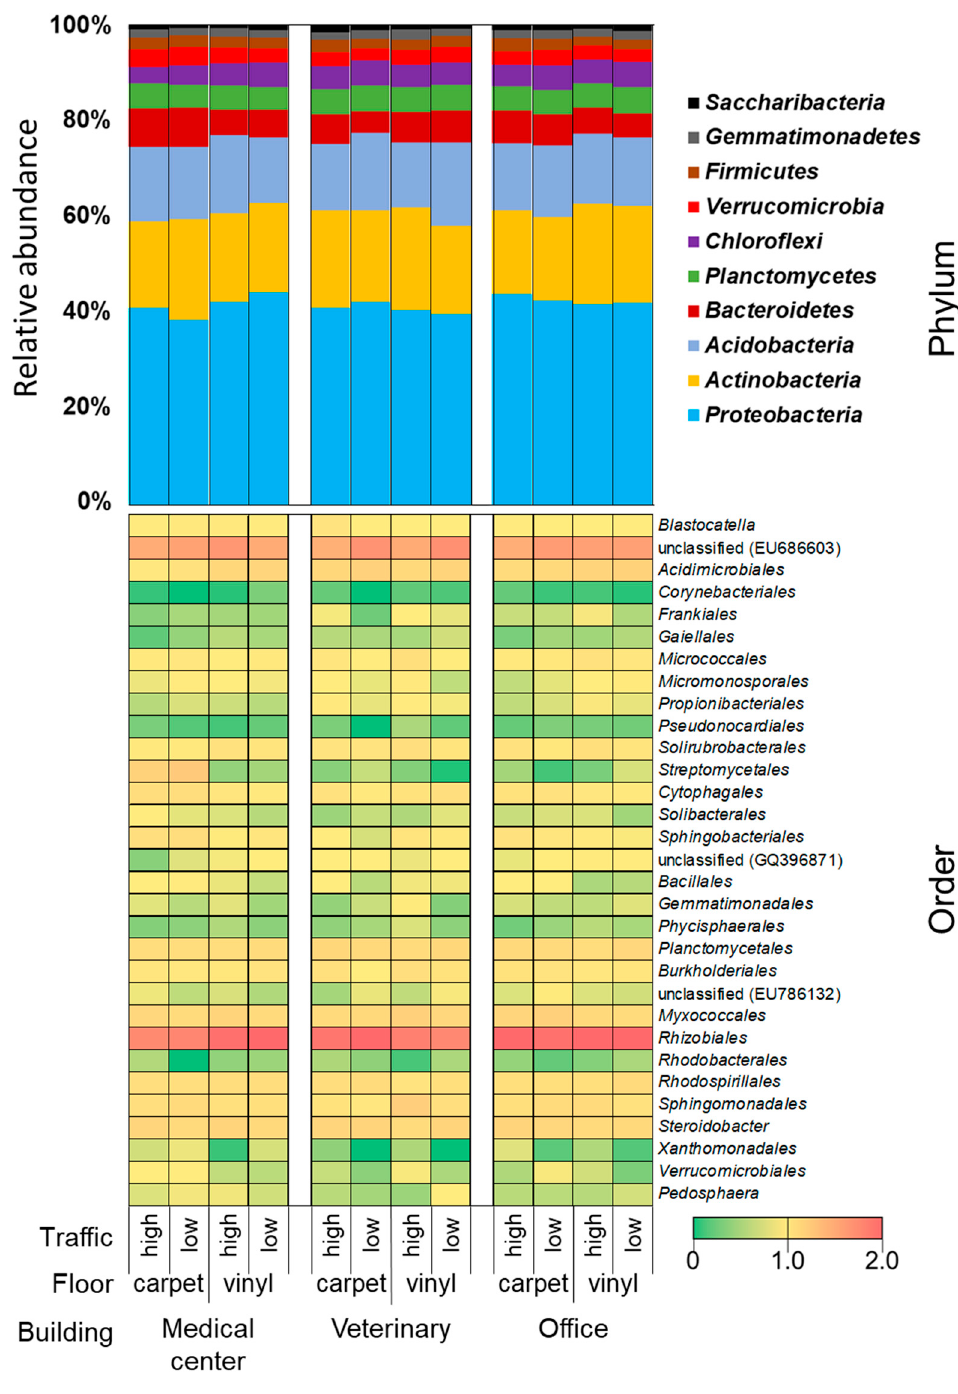
Figure 3. Summary of relative abundance of bacterial community (phylum and order levels) from different floor materials, traffic level and building types.